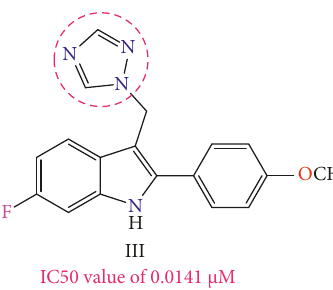
Figure 7: Aromatase inhibition activity of triazole bearing indole derivative (III).